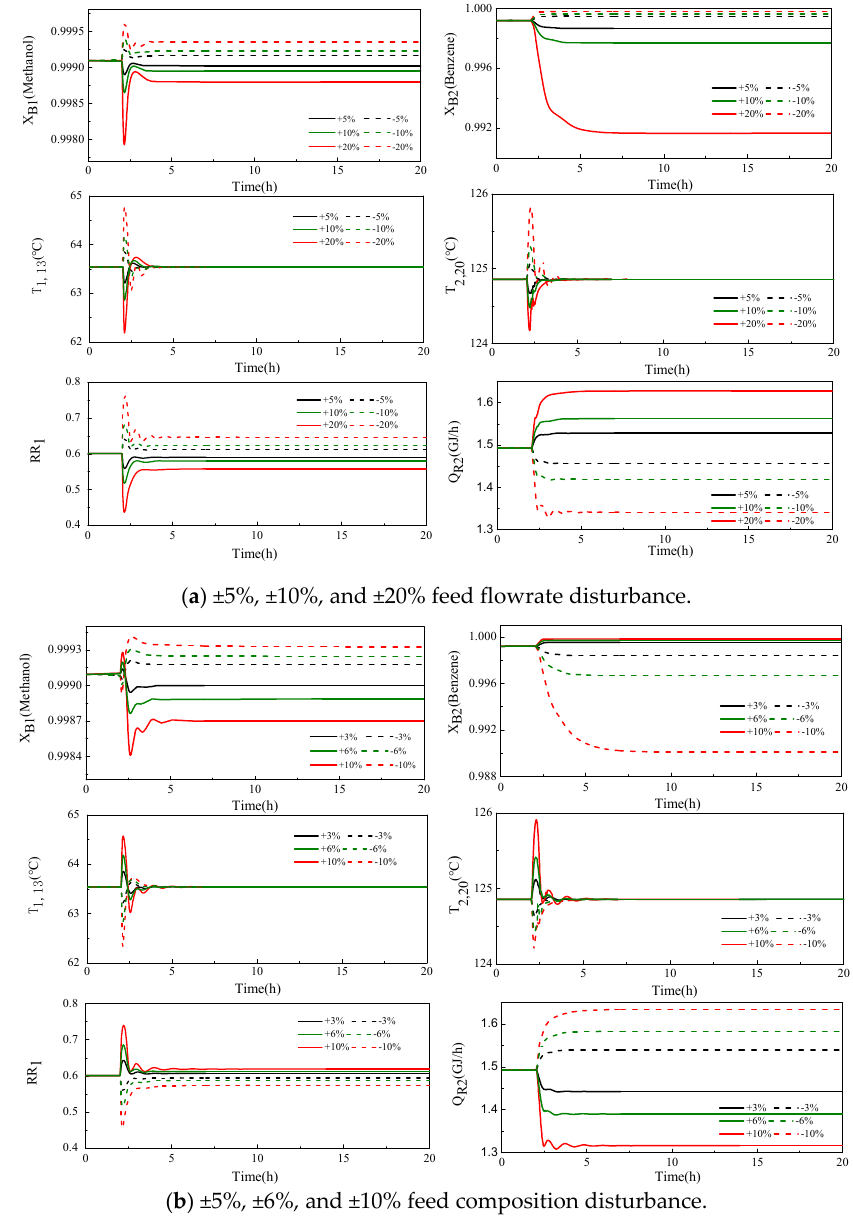
Figure 17. The dynamic responses of the basic control structure.